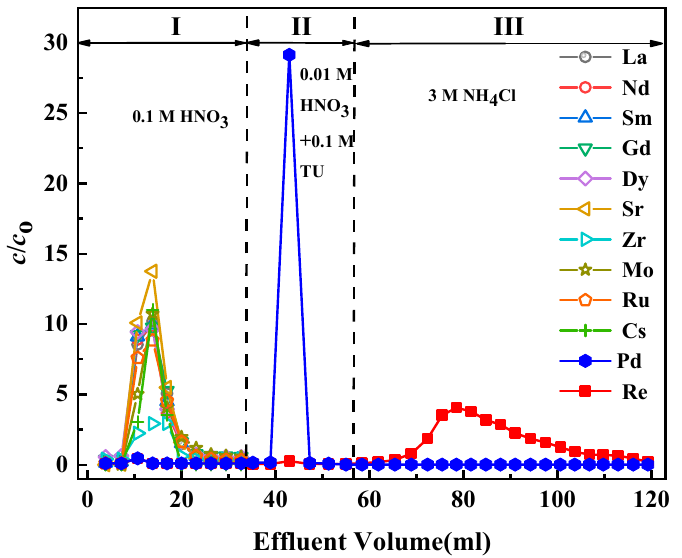
Figure 9. Chromatographic partitioning of Re from a simulated solution by the N3/SiO 2 packed column, with the following adsorption conditions: [M] = 5 mmol/L, [HNO 3 ] = 1 mol/L, and T = 25 °C.